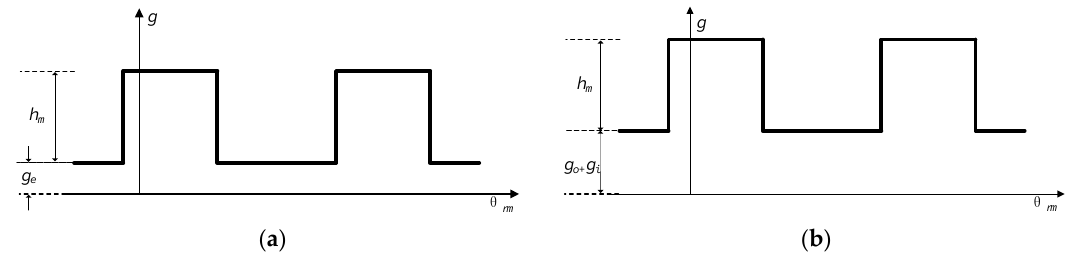
Figure 4. Air gap function of the ( a ) BDFRM motor and ( b ) DSFM motor.